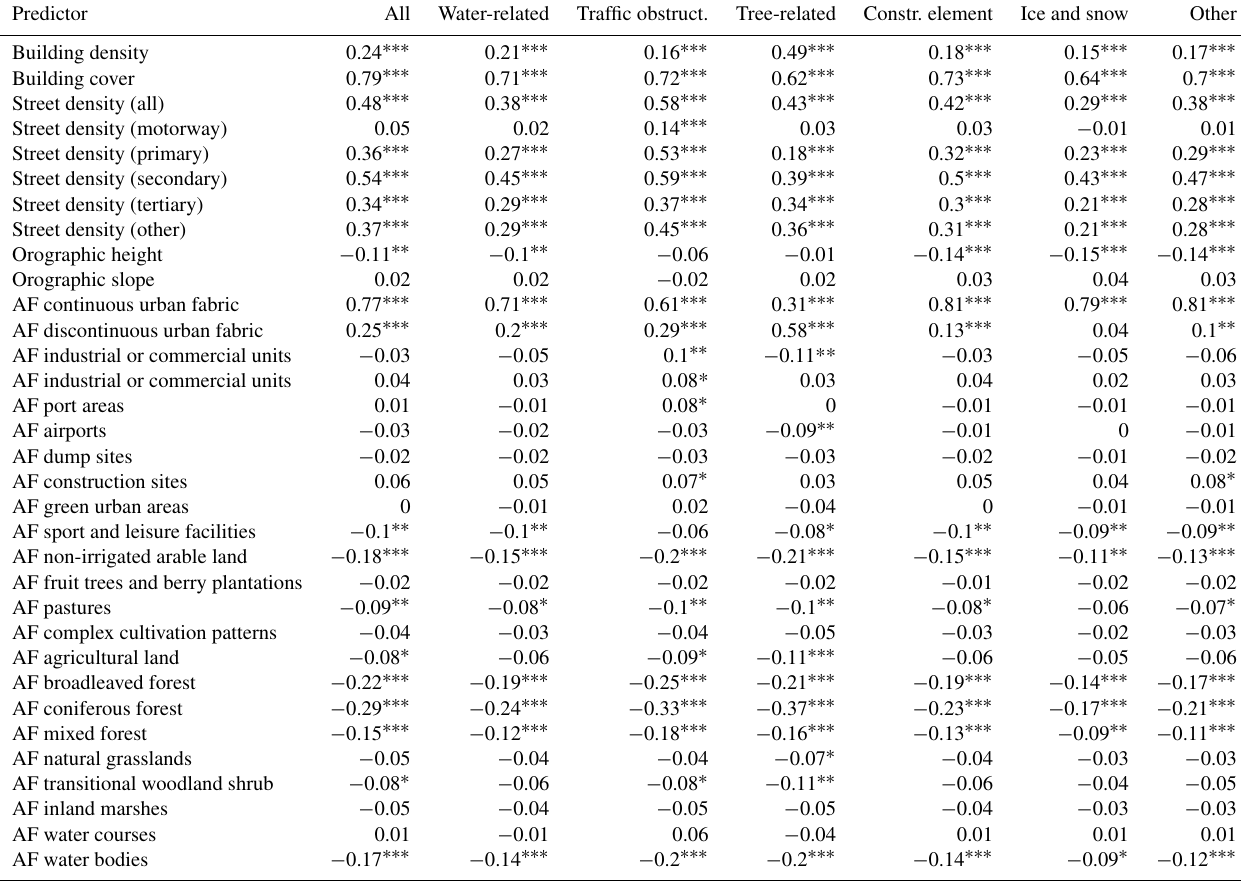
Table 3. Spatial correlation coefficients (Pearson correlation) between yearly averaged operation density with exposure predictors. Some CORINE classes are excluded in this table, if there are no areas in Berlin, and thus the area fraction (AF) is 0 everywhere. High and low correlations are highlighted in red and blue,